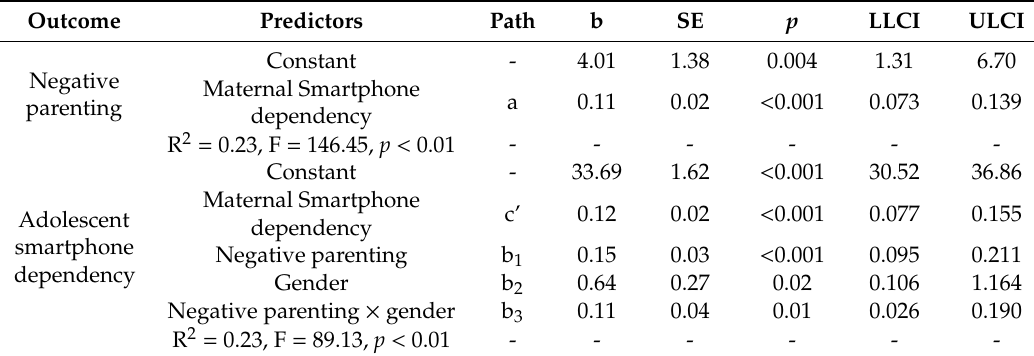
Figure 2. Unstandardized regression coe ffi cient for the moderated mediation model. Table 2. Moderated mediation testing